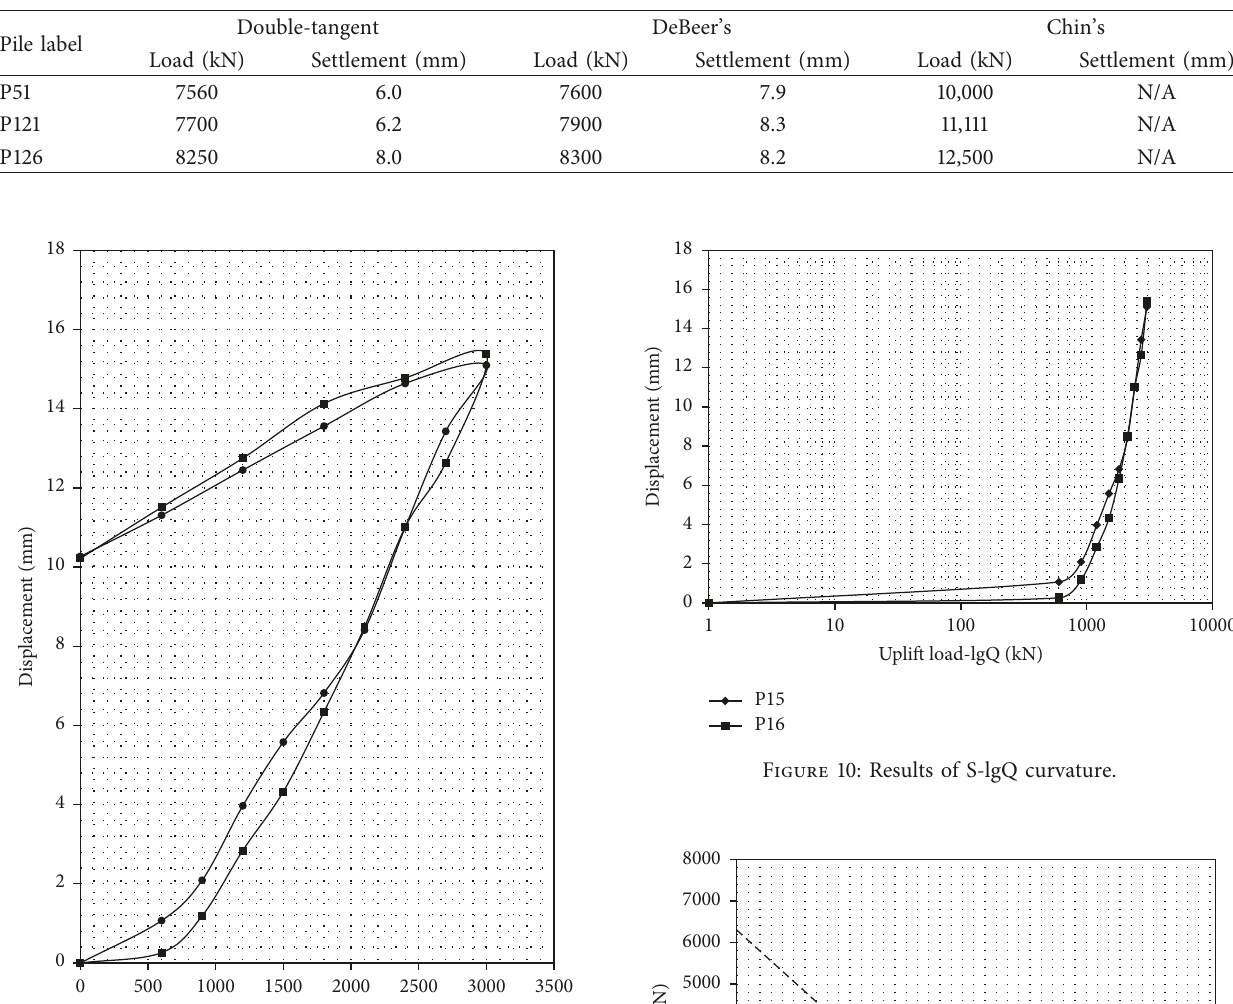
Table 4: Pile capacity based on different methods.